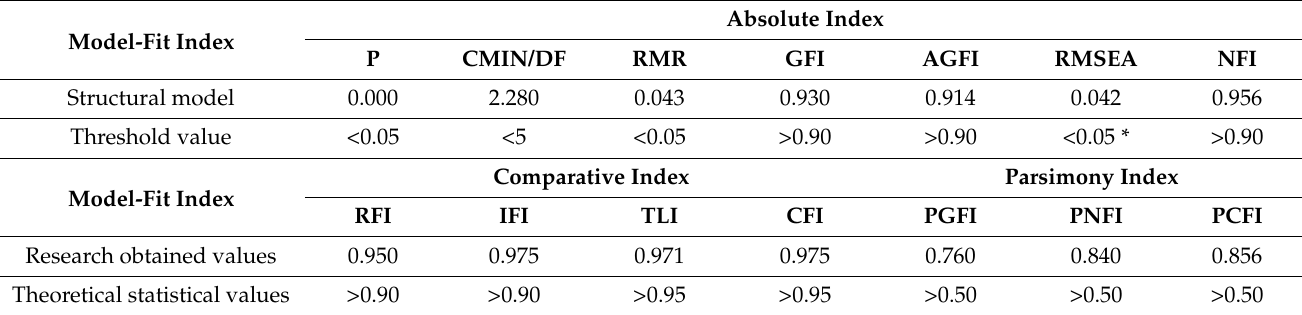
Table 3. Goodness-of-fit indexes.